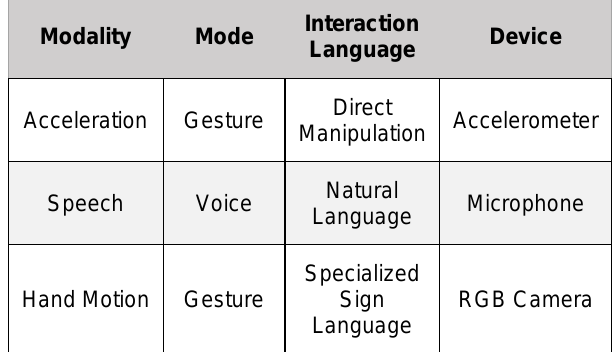
Table 1: Examples of Interaction